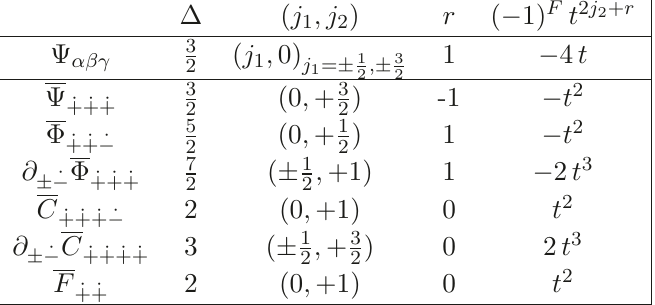
Table 6 . Contribution to the index of the [2] multiplet.